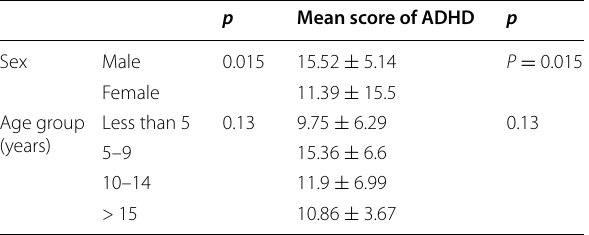
Table 2 The mean and standard deviation of ADHD score by